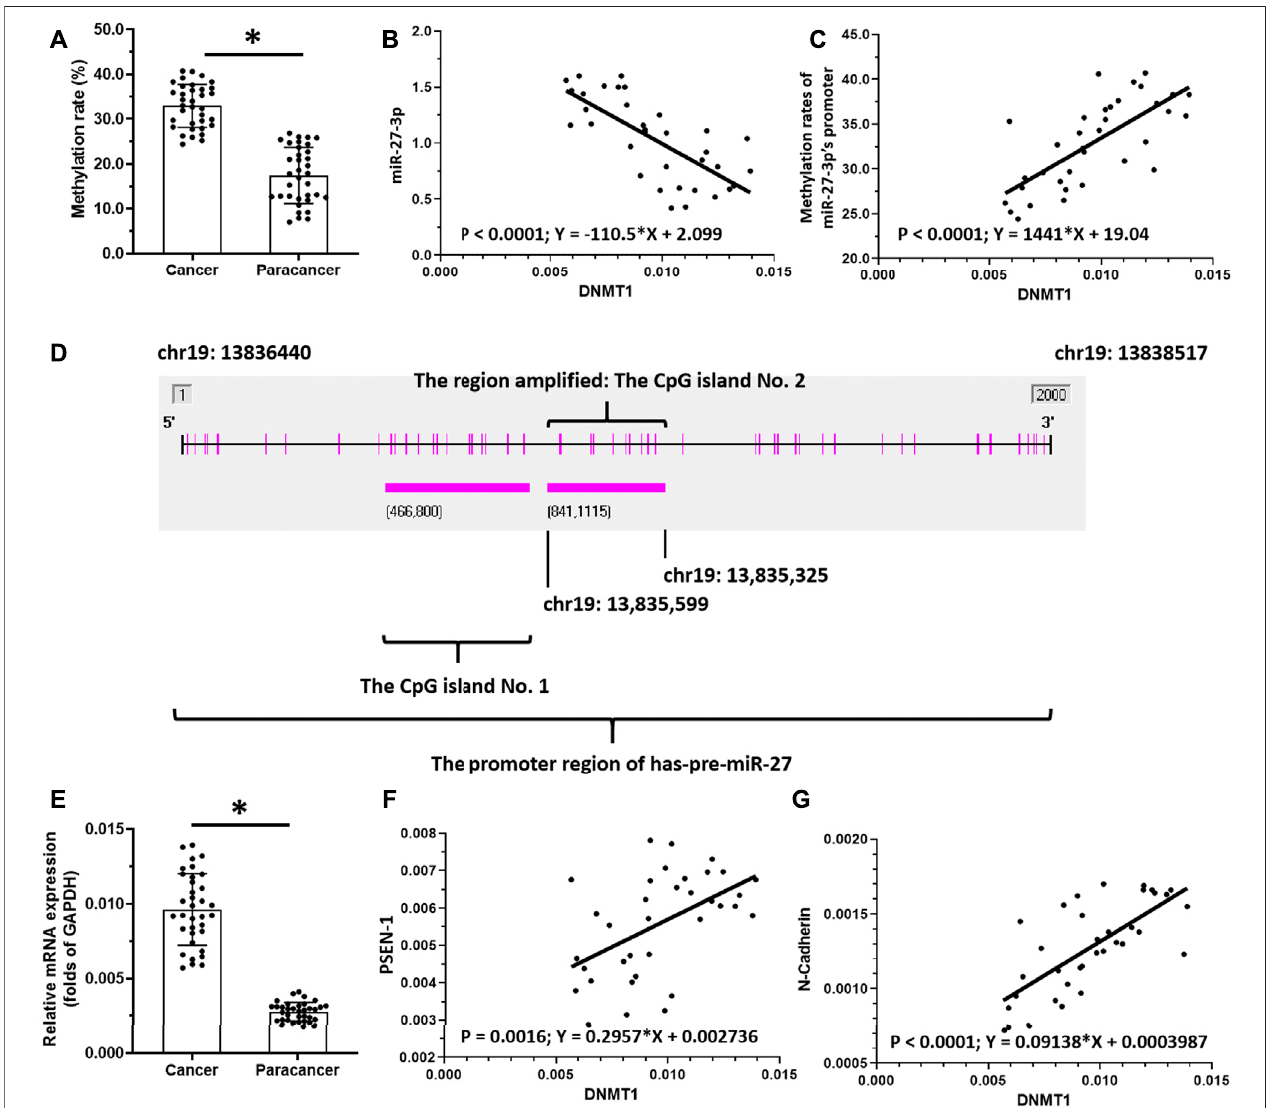
FIGURE 2 | miR-27-3p hypermethylation. (A) Methylation rates of mR-27-3p in LSCC clinical specimens or the paired non-tumor tissues are shown as scatter- plots. (B) Correlation between miR-27-3p and DNMT-1 is shown as scatter-plot images. (C) Correlation between the methylation of miR-27-3p and DNMT-1 is shown as a scatter-plot. (D) Promoter region of miR-27-3p with CpG island. (E) DNMT-1 expression in LSCC or the paired non-tumor tissues is shown as a scatter-plot. (F) CorrelationbetweenPSEN-1andDNMT-1isshownasscatter-plots. (G) CorrelationbetweenN-cadherinandDNMT-1isshownasscatter-plot( n =35).* p < 0.05.